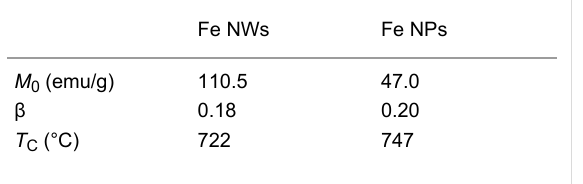
Table 4: Fitting parameters of the magnetic phase transition; M 0 – fitted initial value of magnetization, β – fitted critical exponent, T C – fitted Curie